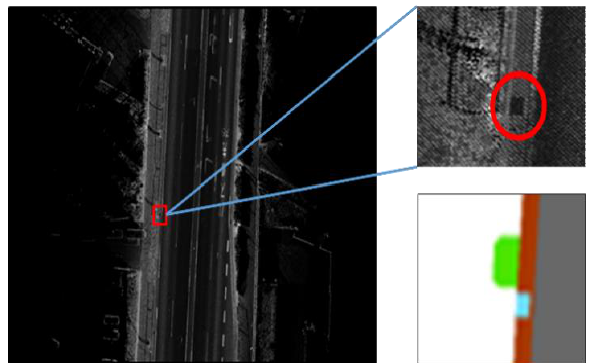
Figure 6. Example of catchment basins in the test